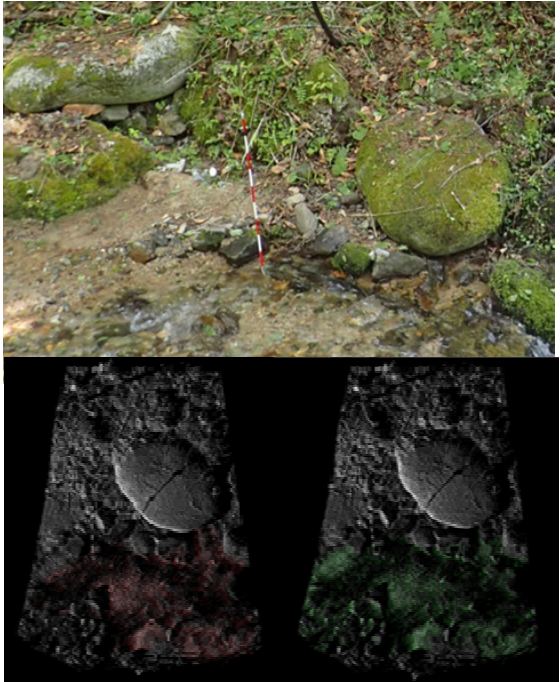
Figure 6. Comparison of water-refraction corrected area in the point cloud of the existing (bottom left) and modified (bottom right) methods, and a photograph in the same area (top). Water flows from left side to right side of the figure.